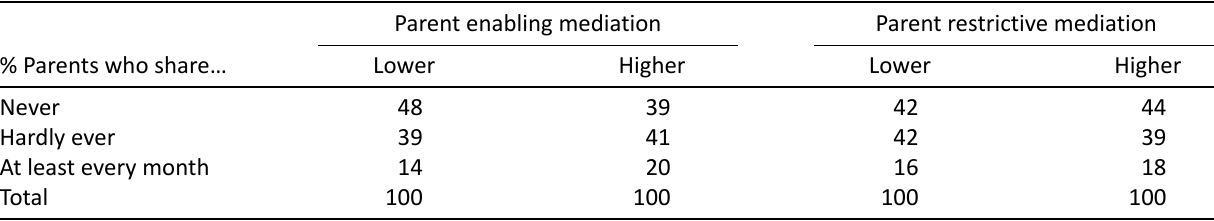
Table 2. How often do you share/post/blog photos/videos of your child online? By parent mediation strategies.